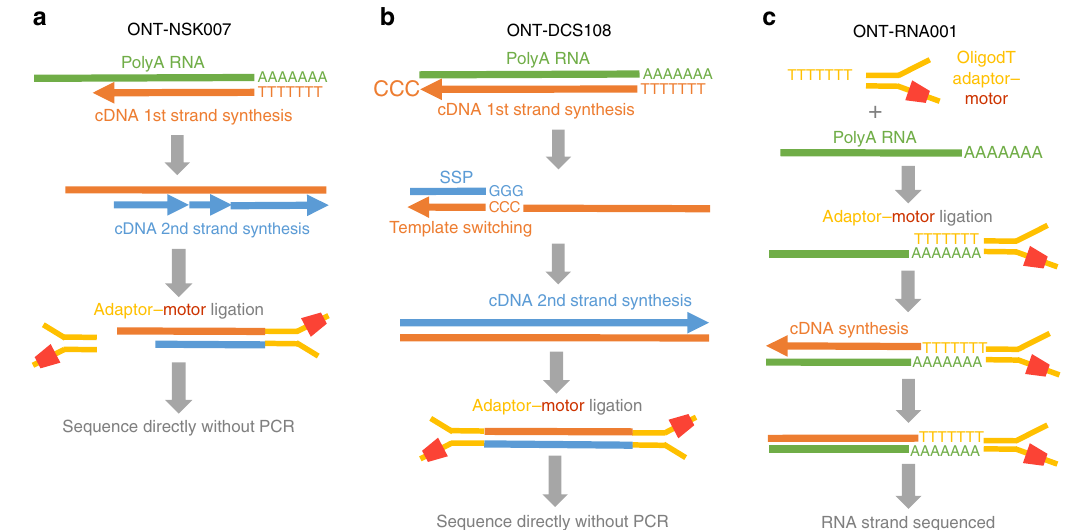
Fig. 1 Overview of library preparation work fl ows used in this study. a In the ONT-NSK007 cDNA library preparation method, polyA RNA is used as a template for fi rst strand cDNA synthesis which is initiated from an oligodT primer. The NEB second strand cDNA synthesis module (E6111) is then used to generate double-stranded cDNAs; here random primers are used to initiate cDNA synthesis, the products of which are then stitched together by